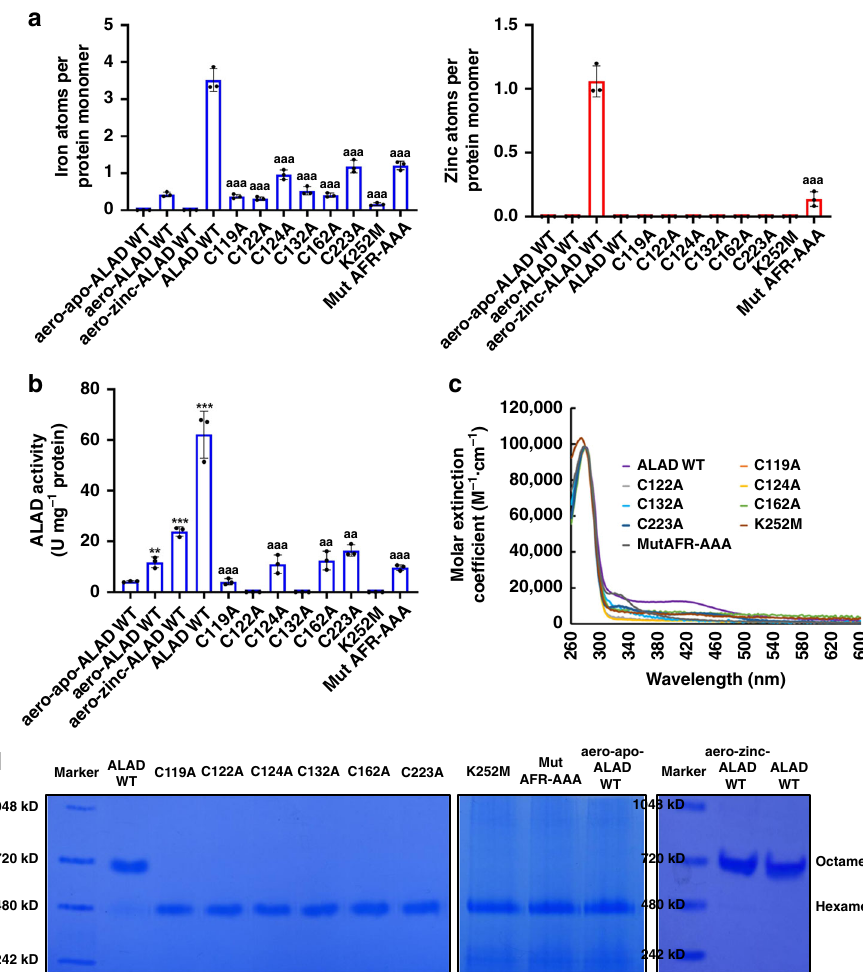
Fig. 2 The [Fe 4 S 4 ] cluster is important for ALAD enzymatic activity in vitro. a ICP-MS analysis and b Enzymatic activity of aerobically puri fi ed apo-ALAD (aero-apo-ALAD WT), aerobically puri fi ed zinc-ALAD (aero-Zn-ALAD WT) and the wild-type (ALAD WT) and mutant ALAD proteins expressed along with the isc operon in E. coli and puri fi ed anaerobically. Results indicate that the [Fe 2 + cluster was important for the enzymatic activity of human ALAD in vitro. The data 4 S 4 ] in panels a and b are presented as mean values±standard deviations of n = 3 biologically independent samples. Two-sided unpaired Student ’ s t -test was employed to analyze statistical signi fi cance. No multiple comparison was performed. **, *** represent P <0.01 and P <0.001, respectively, versus the “ aero-apo-ALAD WT ” group; aa , aaa represent P <0.01 and P <0.001, respectively, versus the “ ALAD WT ” group. The exact P values are provided in the Source Data fi le. c Molar extinction coef fi cients of C119A, C122A, C124A, C132A, C162A, C223A, K252M, and Mut AFR-AAA mutants that were expressed along with the isc operon in E. coli and puri fi ed anaerobically. The results indicated that C119, C122, C124, C132, C162, C223, and K252 of human ALAD were important for [Fe 4 S 4 ] cluster coordination and/or retention, and the AFR motif was important for [Fe 4 S 4 ] cluster acquisition. d Native gel electrophoresis analysis of wild-type and mutant ALAD proteins expressed along with the isc operon in E. coli and puri fi ed anaerobically, the aero-apo-ALAD WT protein, and aero-Zn-ALAD WT protein (See Supplementary Fig. 8 for the full Zn- ALAD WT native gel). This experiment was repeated three times independently with similar results. The results suggest that [Fe 4 S 4 ] cluster coordination correlated with increased proportions of ALAD